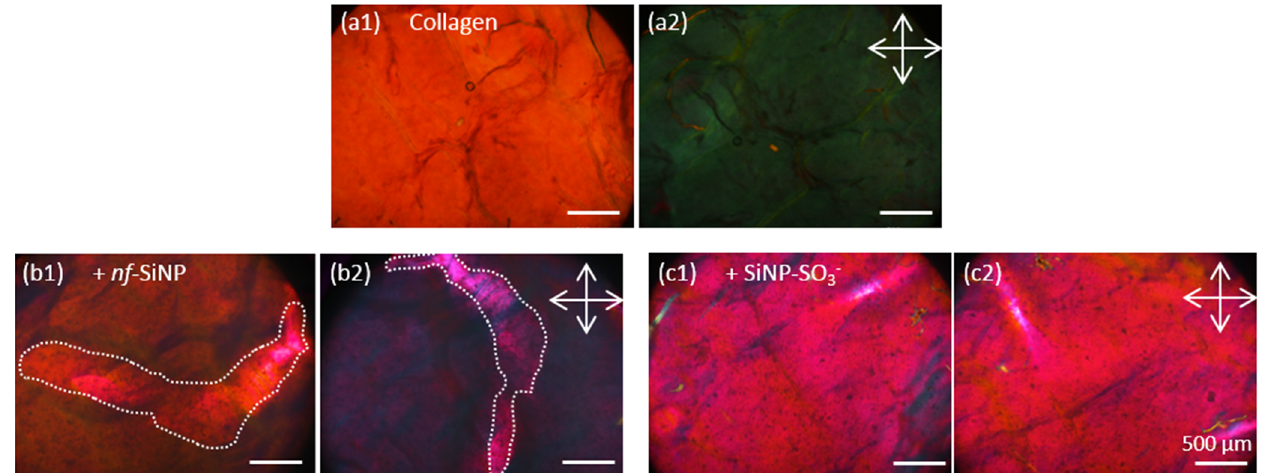
Figure 4. PLM images of ( a ) collagen films and composites with ( b ) nf -SiNP and ( c ) SiNP-SO 3 − after EDC crosslinking. ( 1 ) and ( 2 ) stand for PLM imaging performed by taking 2 serial images with the sample oriented vs. the cross polarizers (white arrows) at maximal transmission ( 1 ) and at extinction ( 2 ). A waveplate was added to improve contrast.